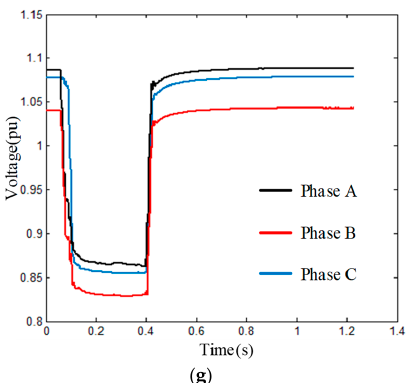
Figure 1. ( a ) A-phase short-circuit fault, ( b ) B-phase short-circuit fault, ( c ) C-phase short-circuit fault, ( d ) AB-phase short-circuit fault, and ( e ) AC-phase short-circuit fault, ( f ) BC phase short circuit fault, ( g ) ABC phase short circuit fault.